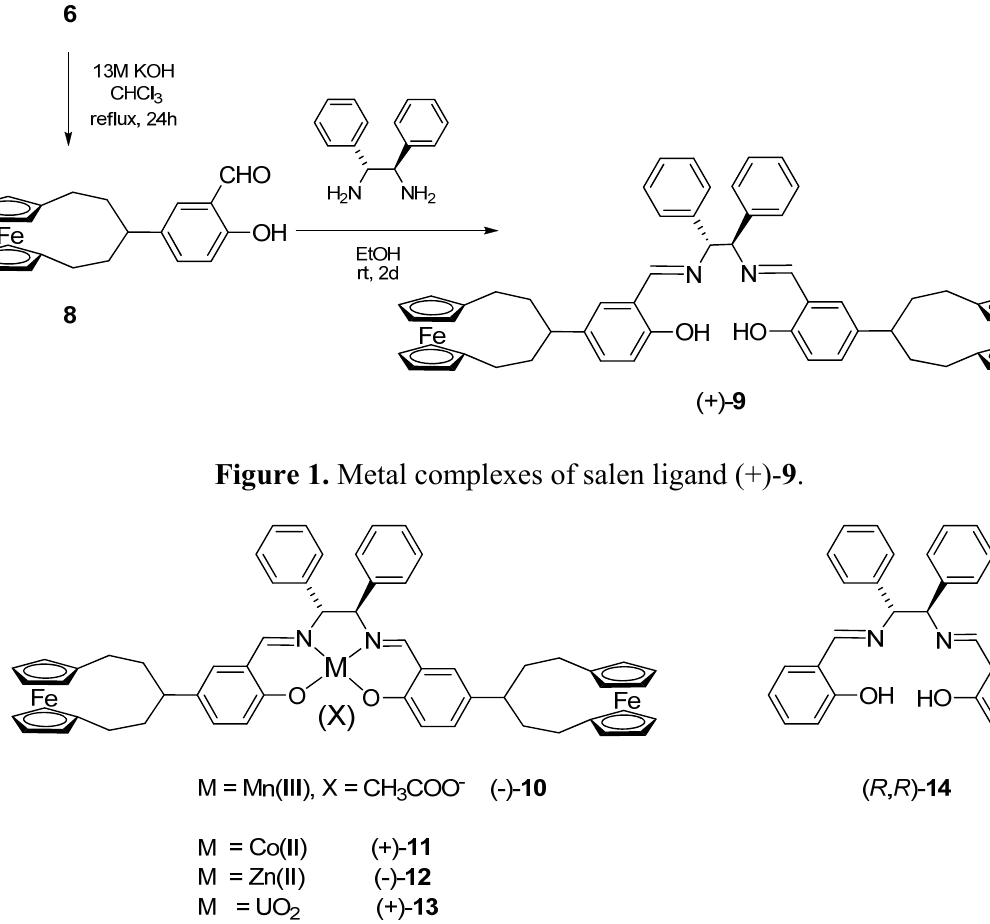
Figure 1. Metal complexes of salen ligand (+)- 9